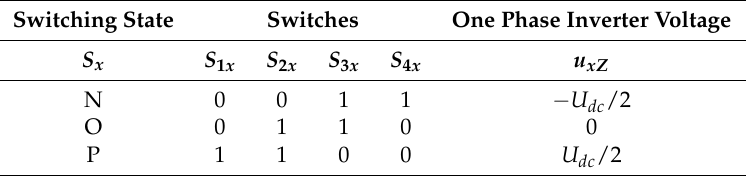
Figure 1. Simplified configuration of the grid-connected 3L-T-type inverter. Table 1. Operating principle of inverter branch x